Question: Condense the content of this figure into a single sentence.
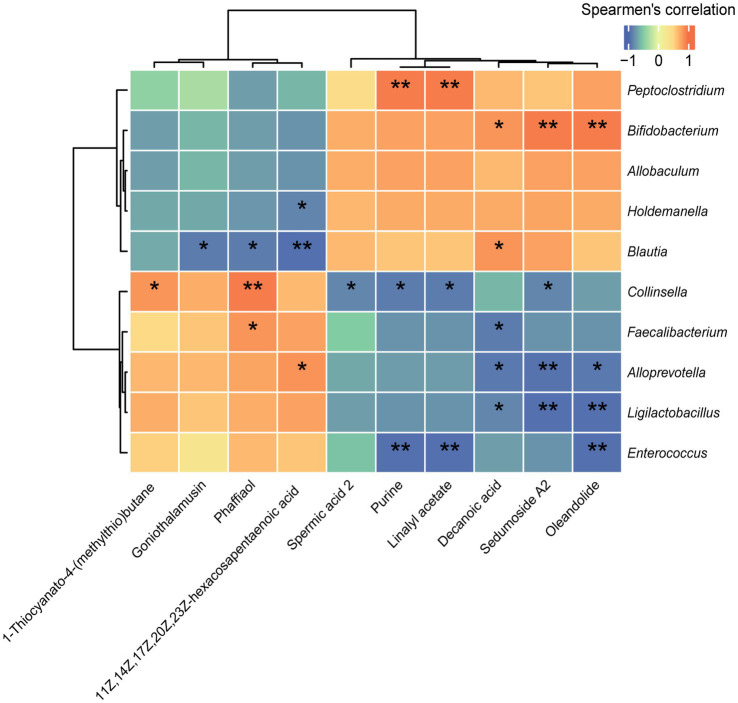
Answer: Correlational analysis of differential metabolites and microbes. The top 10 differential metabolites regarded as fold change (FC) and microbes regarded as p -value at the genus level were selected to conduct correlational analysis using Pearson’s method. Red and blue ellipses mean positive and negative correlation, respectively. *means significant correlations ( p < 0.05) between the metabolite and the microbe. **means significant correlations ( p < 0.01) between the metabolite and the microbe.